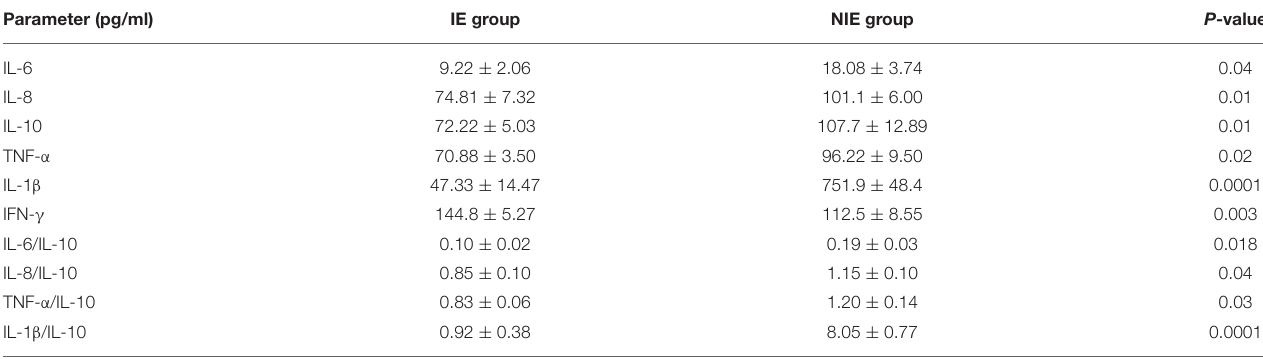
TABLE 3 | Changes of inflammatory cytokines in the NIE and IE groups.